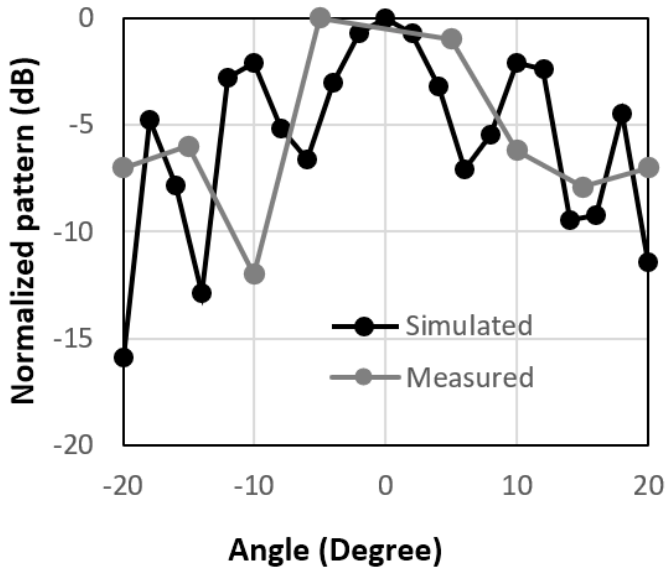
Figure 6. Normalized radiation patterns for circular patch-type unit cells at 3.5 GHz.